Question: What type of chart is this?
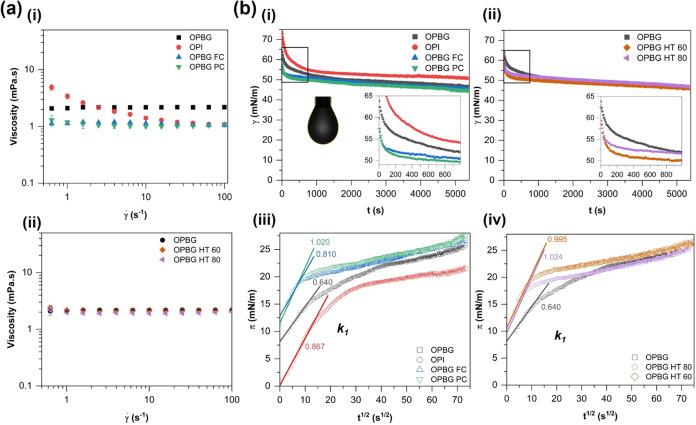
Answer: line